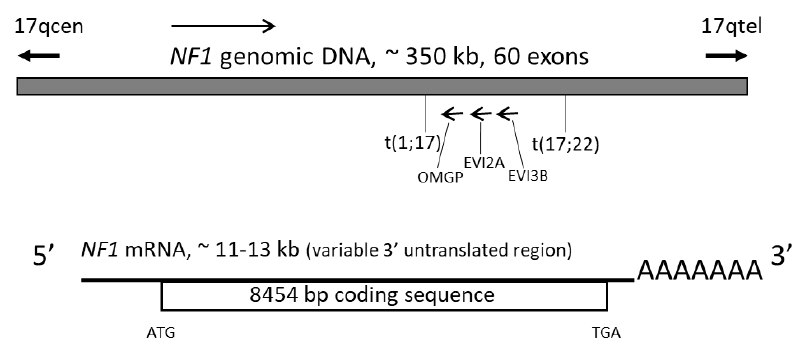
Figure 1. Schematic representation of the NF1 gene and its mRNA transcript; kb: kilo bases Three active genes lie within intron 35 (27b in the previous numbering) of NF1 and are transcribed from the opposite strand: EVI2A (ecotropic viral integration site) [13], EVI2B [14], and OMGP (oligodendrocyte myelin glycoprotein) [15] (Figure 1). EVI2A and EVI2B are the human homologues of the murine Evi-2A and Evi-2B genes, which encode proteins involved in retrovirus- induced murine myeloid leukemogenesis [13,14]. OMGP encodes a glycoprotein specifically expressed in oligodendrocytes [16]. None of these genes have been found to be mutated in NF1 patients [13–15].